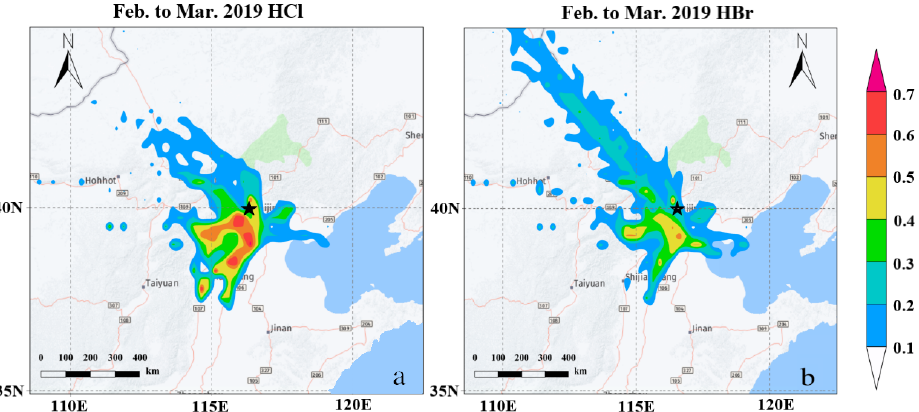
Figure 6. The results of PSCF analysis for HCl (a) and HBr (b) . Darker colors indicate greater potential source distribution. The terrain base map was made from © Yahoo Maps. Black stars mark the location of the sampling site.